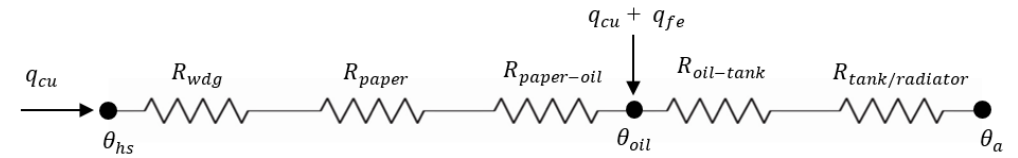
Figure 3. Thermal resistance equivalent circuit with heat source.